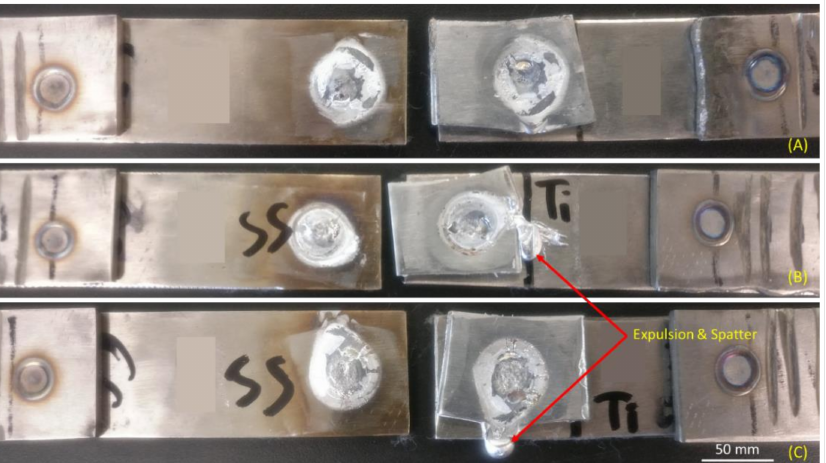
Figure 3. Resistance spot welded joint appearance after tensile-shear test under different generated heat inputs: ( A ) 65.6 kJ; ( B ) 78.1 kJ; ( C ) 91.6